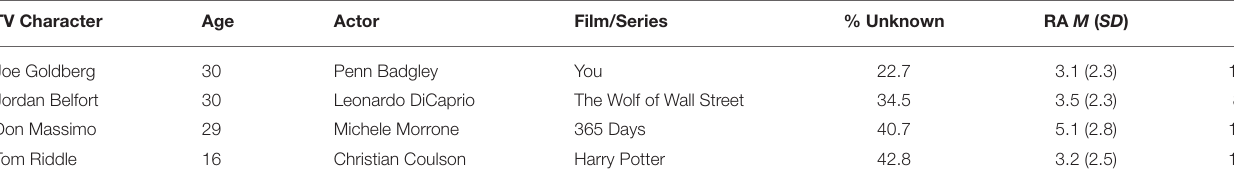
TABLE 5 | Final selection of included villainous TV characters in Study 2 (Main Study).